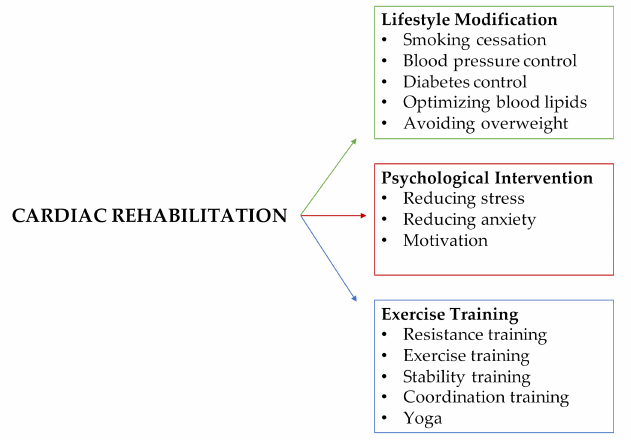
Figure 1. The main measures of cardiac rehabilitation: lifestyle modification, psychological interven- tion, and exercise